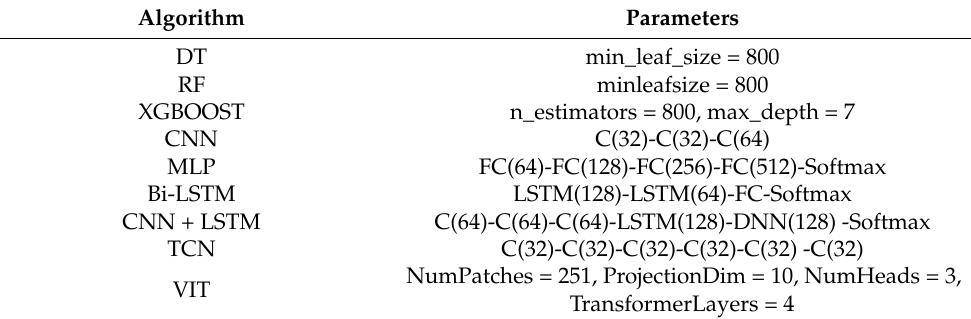
Table 2. Parameters specifically modified in